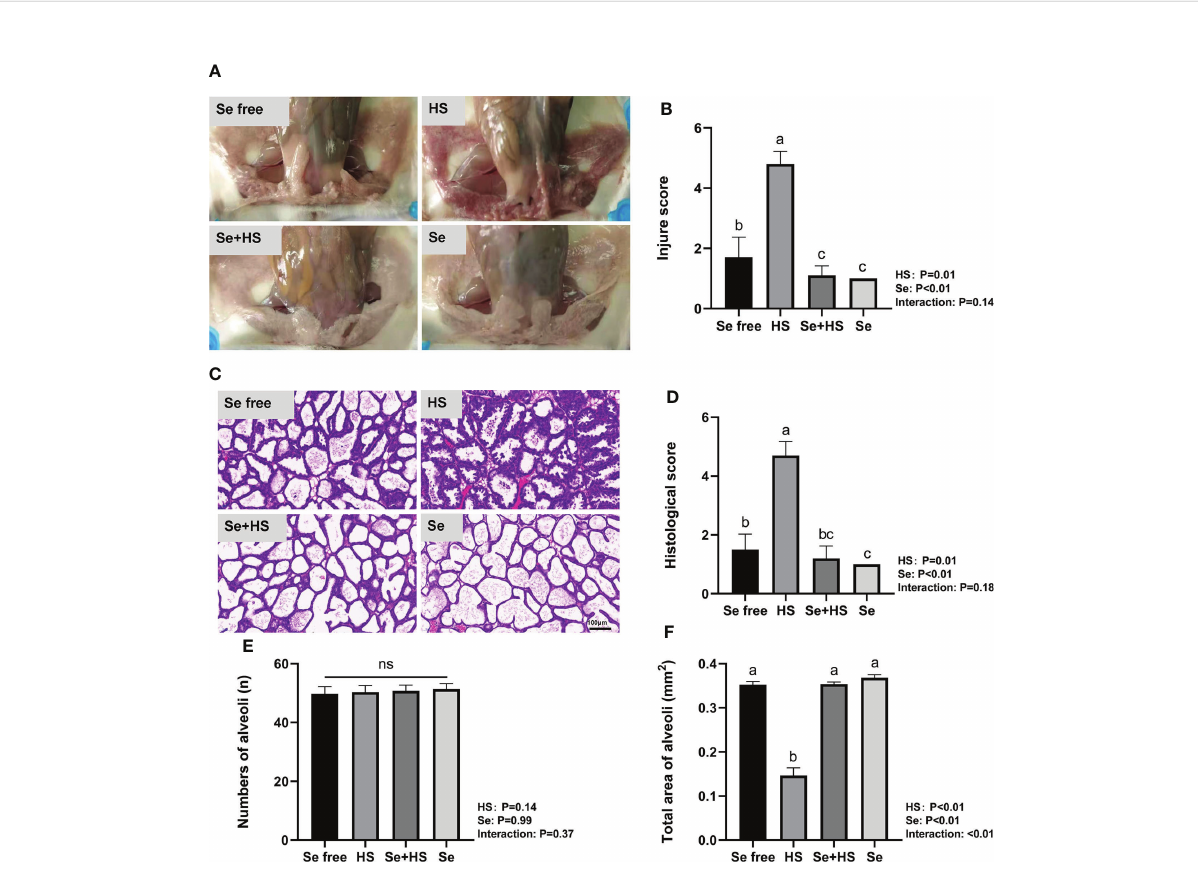
FIGURE 7 EffectsofHMSeBAonmammaryglandtissueofmiceunderHS(n=12). (A) Clinicalscore. (B) Clinicalscore. (C) hematoxylin-eosin-stainedpathological sections. (D) Histologicalscore. (E) Numberofalveoli. (F) Totalareaofalveoli. a-d Differentlowercaselettersindicateextremelysigni fi cantdifferencesbetween twogroups( P <0.01),whilethesamelowercaselettersindicatenosigni fi cantdifferencebetweentwogroups( P >0.05).ns,nosigni fi